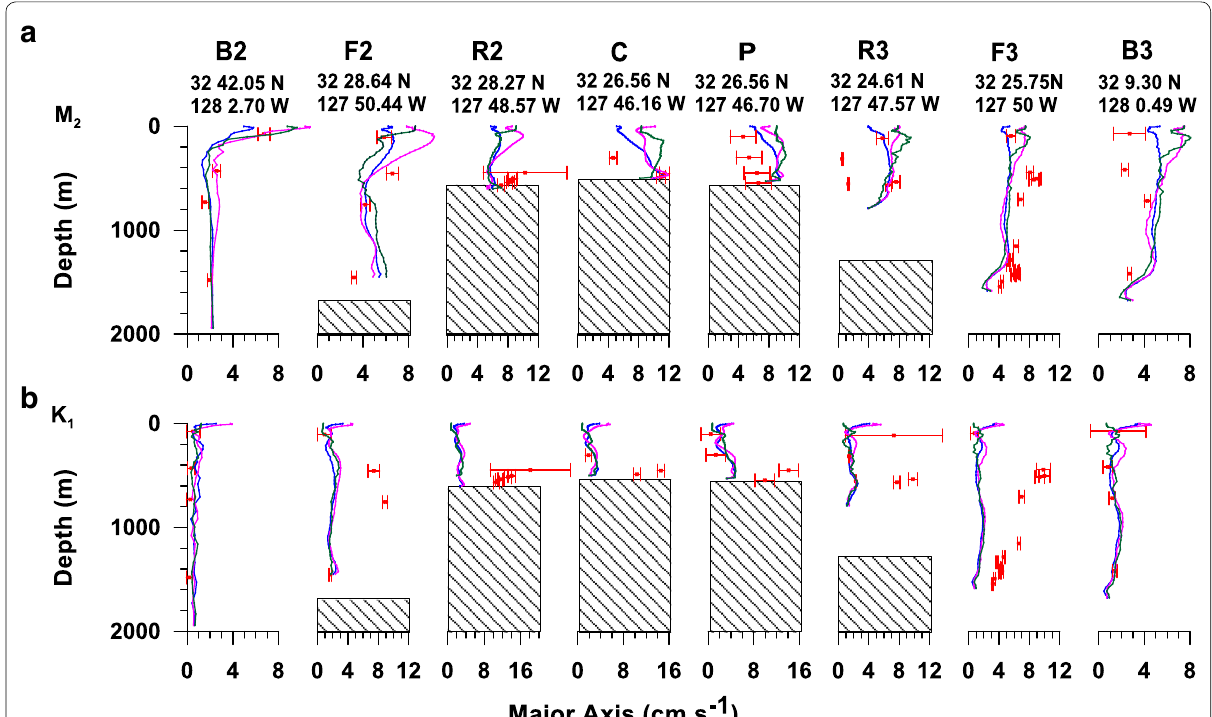
Fig. 3 Comparison of the major axes of the tidal ellipses from the model to the observations at the mooring locations for a M 2 and b K 1 . Model results are indicated by profiles with dots at the levels in green for LMD, magenta for MY, and blue for NN. The observational values are represented by red crosses with the observational uncertainty range indicated by error bars. The mooring latitudes and longitudes are given and the hatching indicates the observed water